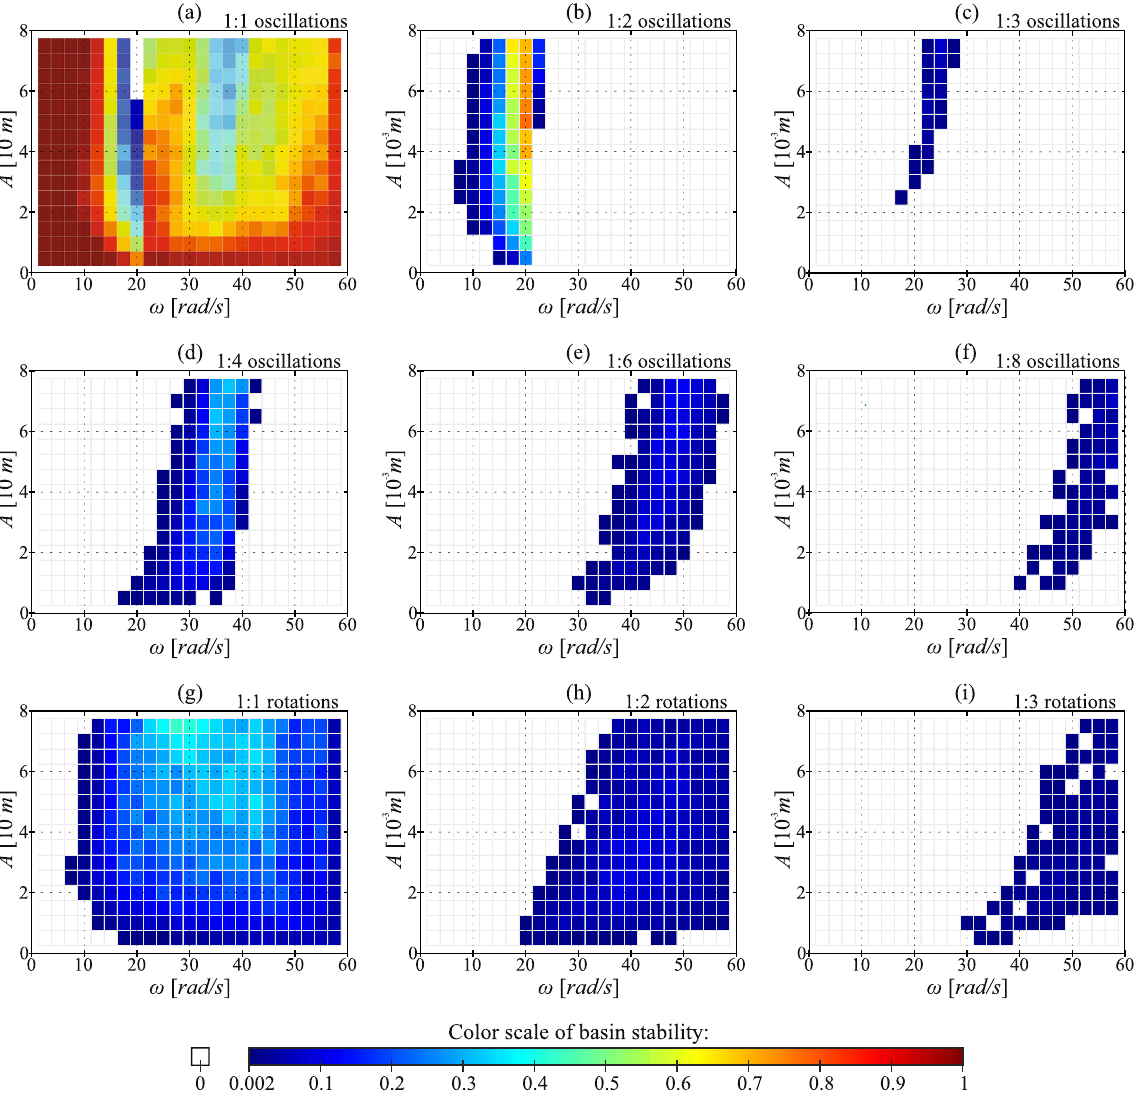
Figure 4. Two parameters maps of the basin stability for the 9 investigated solutions. The grid corresponds to the lattice used during the calculations. Below is the common basin stability scale used for all 9